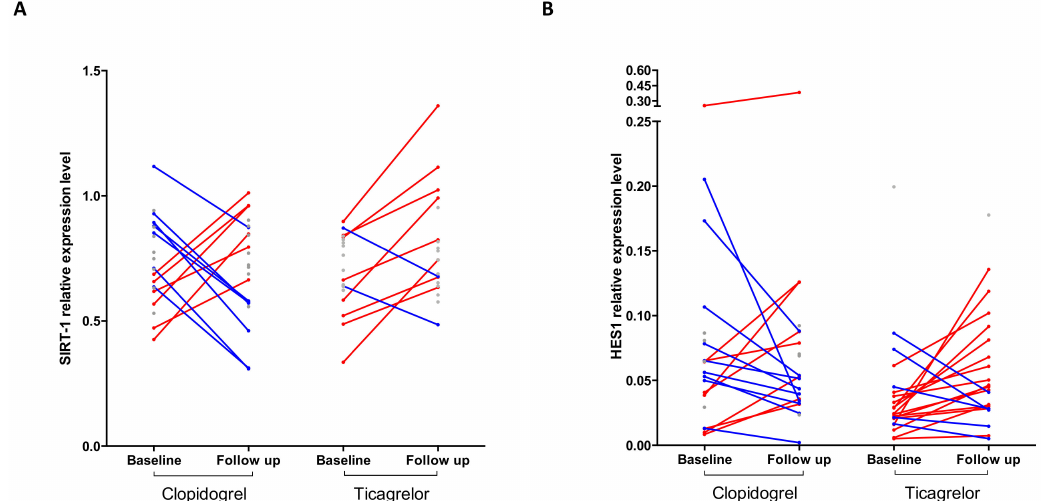
Figure 3. Before-after analysis of SIRT1 and HES1 . Before-after plot of SIRT1 ( A ) and HES1 ( B ) gene expression in peripheral blood cells from patients before and after one month of treatment with clopidogrel or ticagrelor. For clarity, only changes in gene expression higher than 20% of the values at baseline are connected and color-coded (red for fold changes > 1.2 and blue for <